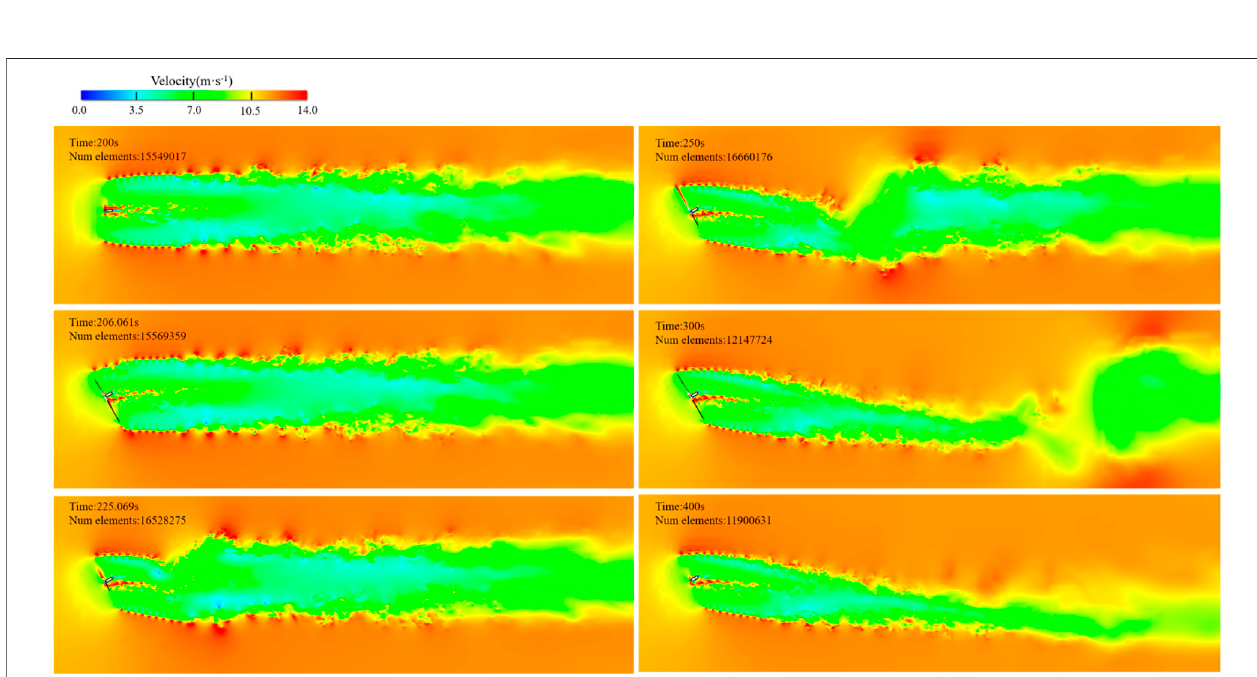
FIGURE 10 | Instantaneous velocity contour of the horizontal section at the hub height under the rapid dynamic yaw.